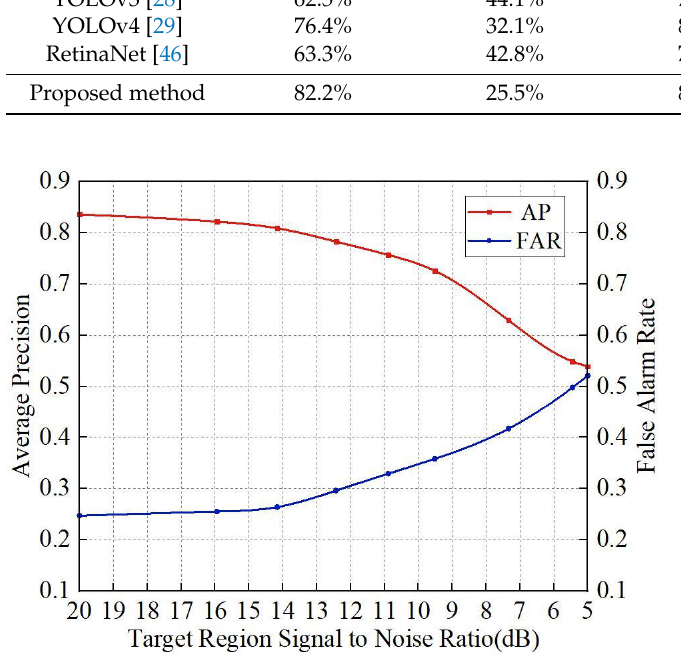
Figure 8. Variation curves of the AP and